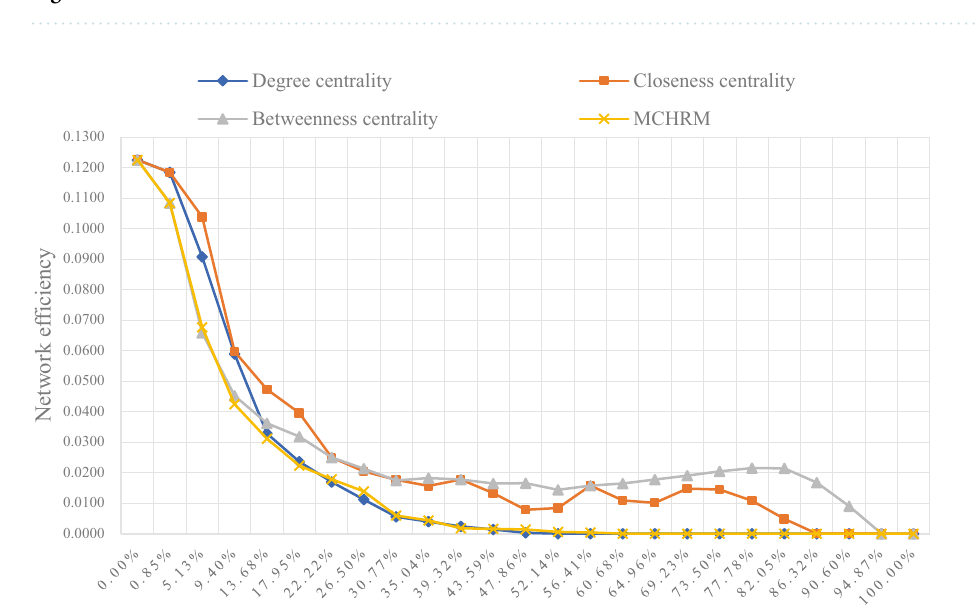
Figure 5. Mode of